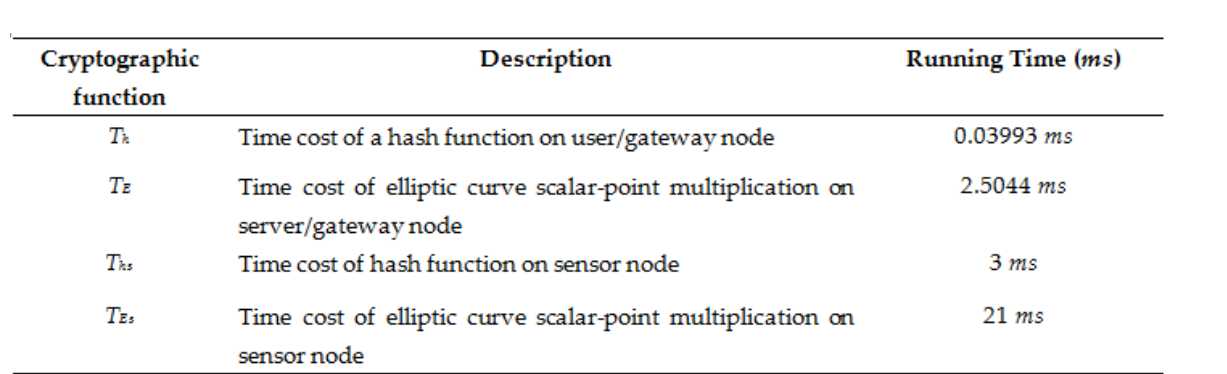
Figure 9. Comparison of security and functional features [15,19,21,22,27,34].